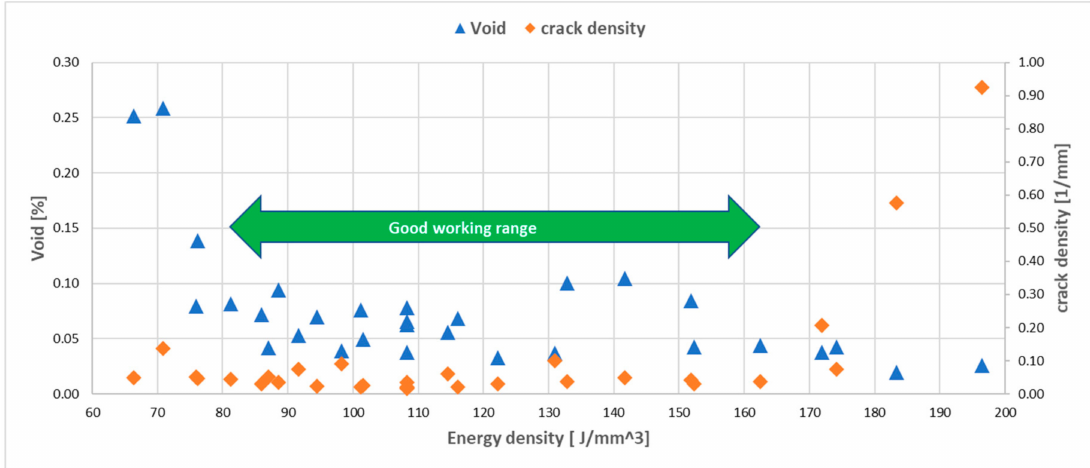
Figure 23. Energy density working range, in which low void content and crack density are